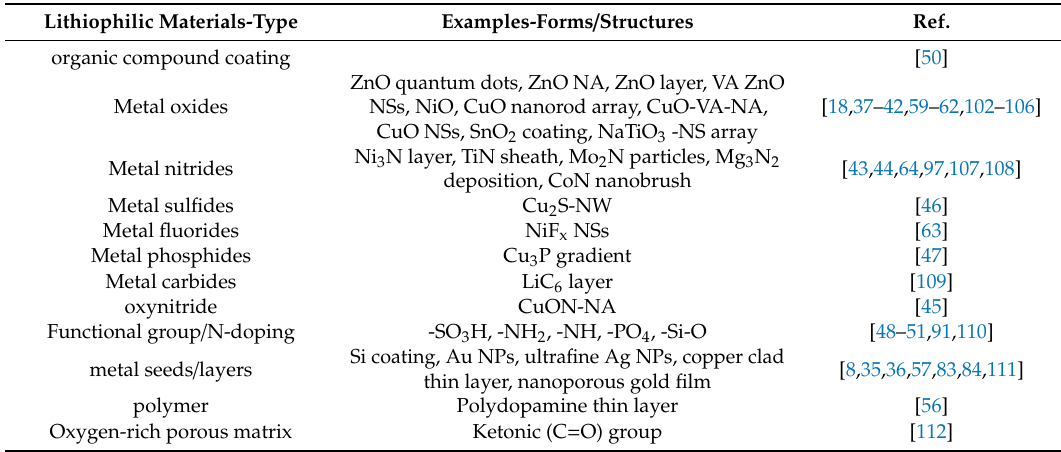
Table 3. Summary of the lithiophilic materials used in the porous metal / carbon framework of LMBs. Lithiophilic